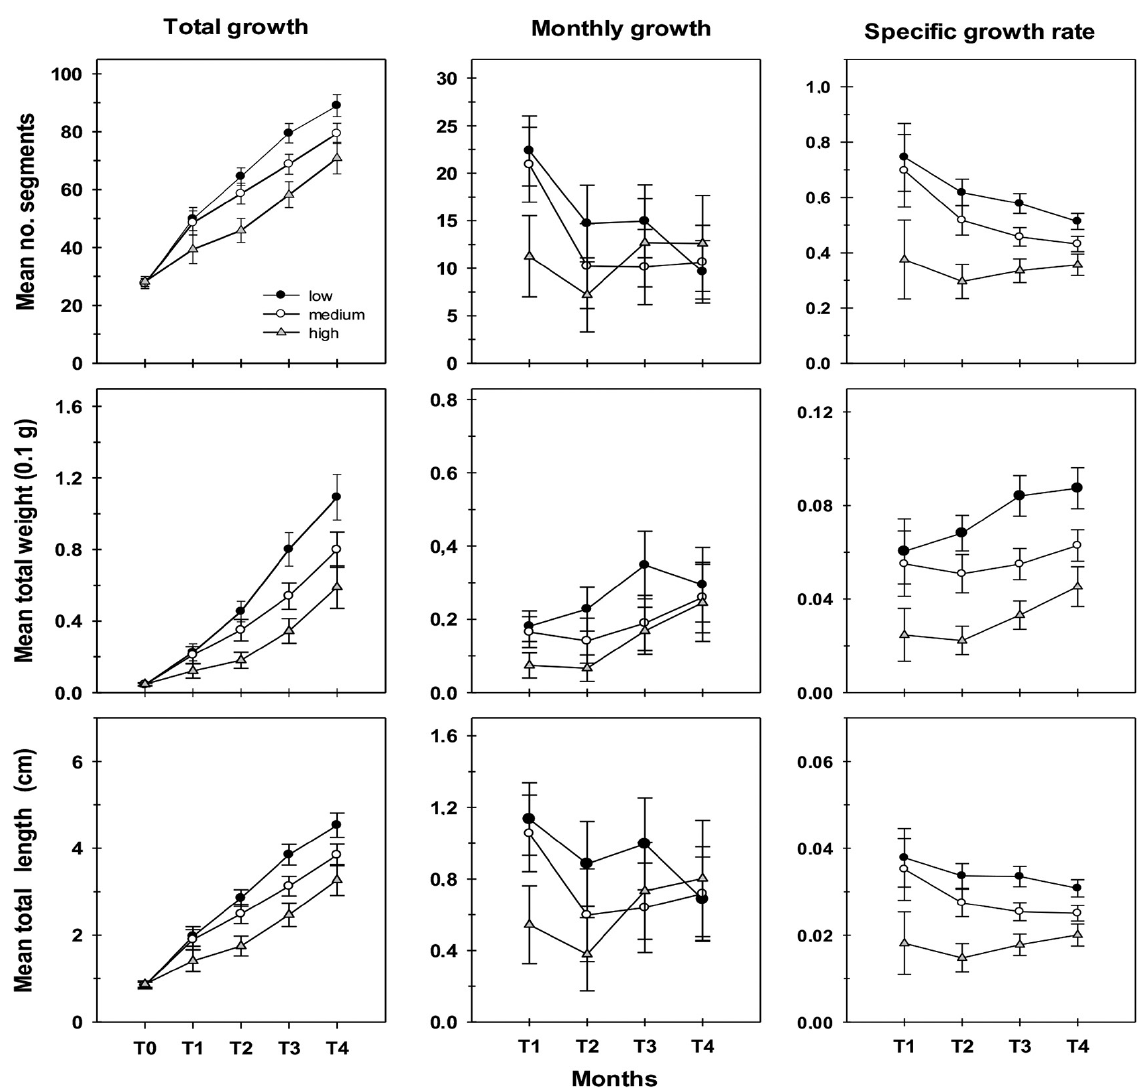
Fig. 4. – Monthly Growth of Marphysa “sp.” at each density level (low, medium and high). T